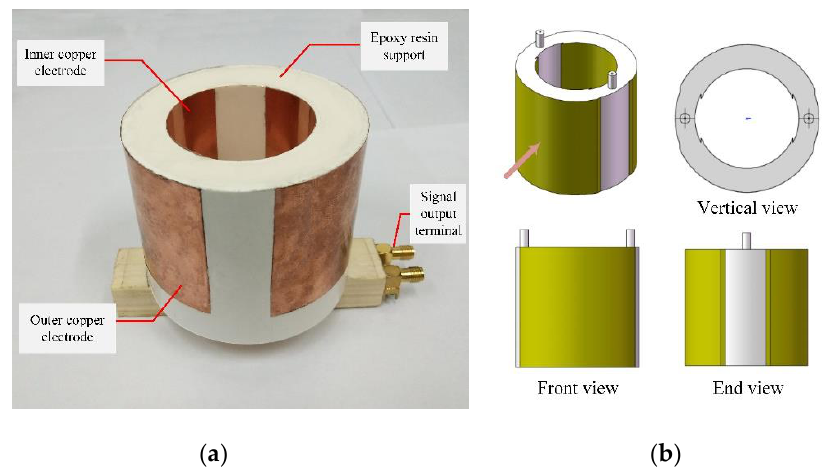
Figure 9. The physical picture and orthographic views of Dual-Differential D-dot sensor: ( a ) Physical picture; and ( b ) Orthographic views.